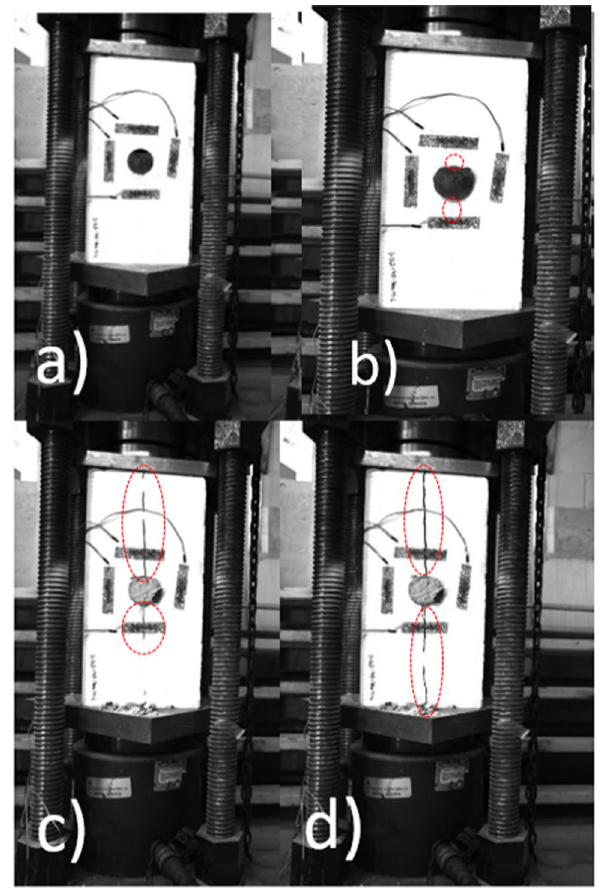
Fig. 19 G-SL2-175-700-M-L a At time t Breakage at t 9 d Complete breakage t 9.73